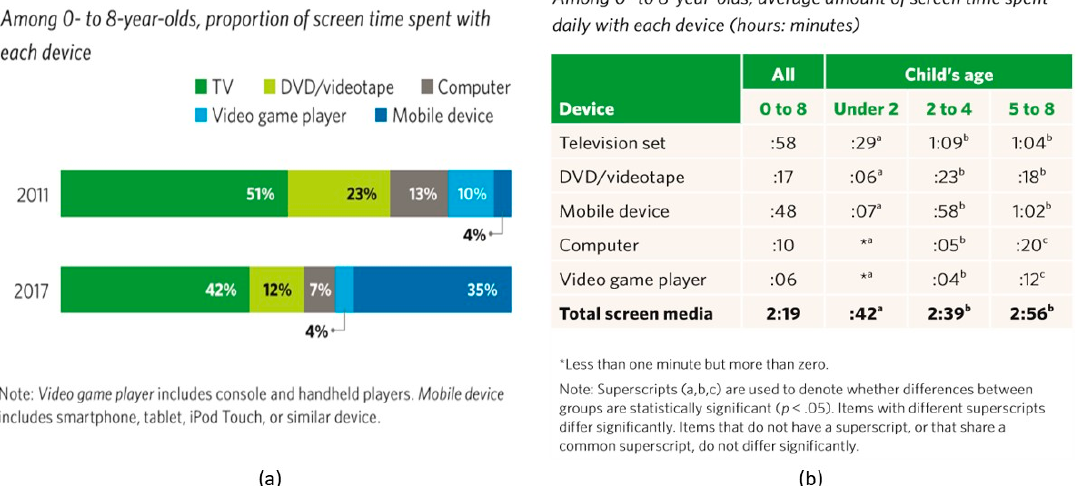
Figure 1. Screen Media use by device: ( a ) portion of screen time spent with each device in 2011 and 2017; ( b ) average amount of screen time spent daily with each device (hours: minutes).